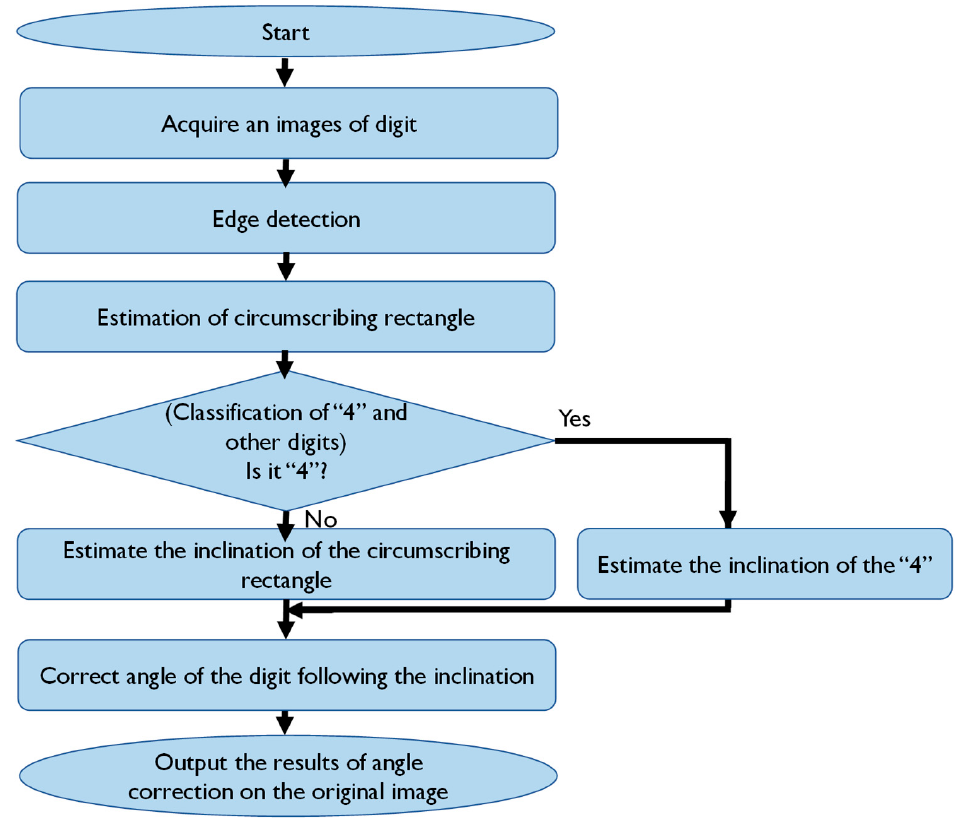
Figure 3. Overall processing flow of tilt estimation and correction.